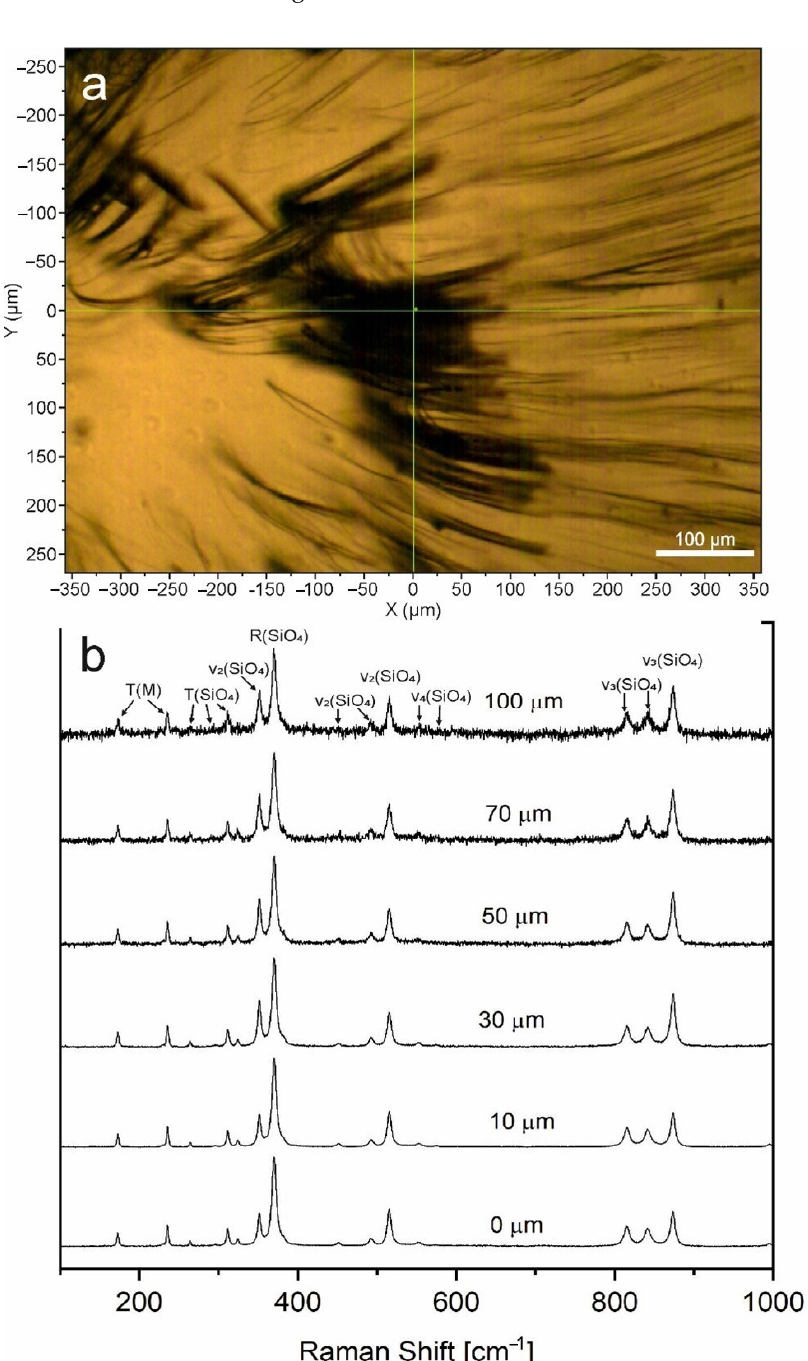
Figure 11. Raman spectrum of the Demantoid from the Poldnevskoye deposit: ( a ) optical image of the “horsetail” inclusion in the demantoid (thin sections); and ( b ) Raman spectra of inclusions in the depth range of 0–100 µ